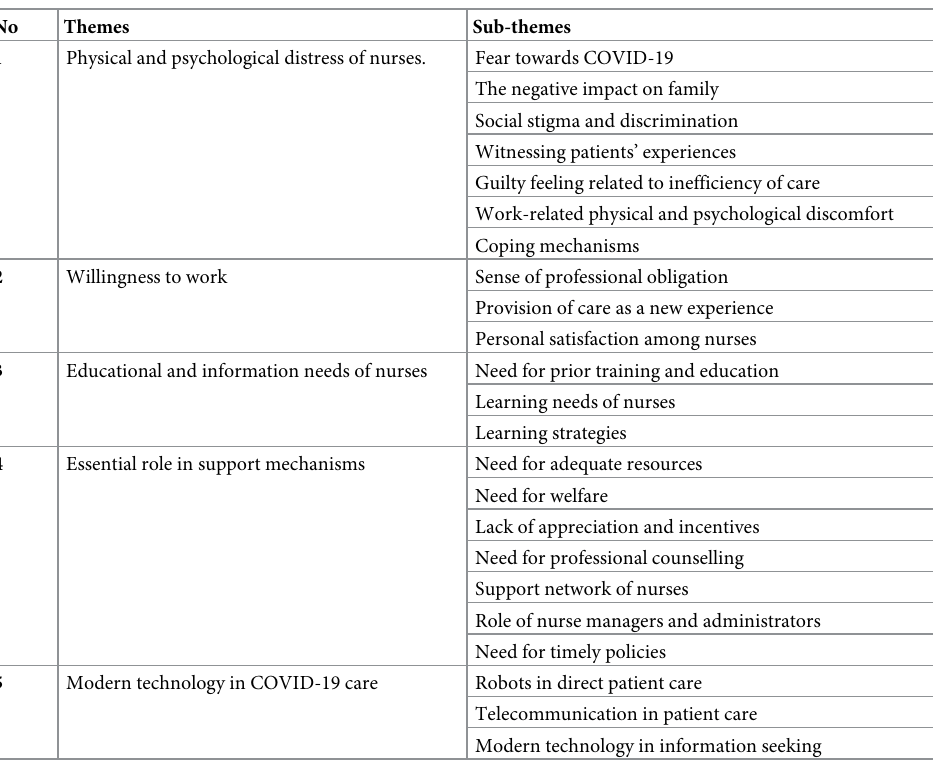
Table 3. Themes and